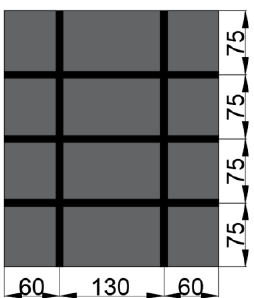
Figure 5. Inner- and outer-leaf wall-panel-reinforcement diagram (Unit: mm).